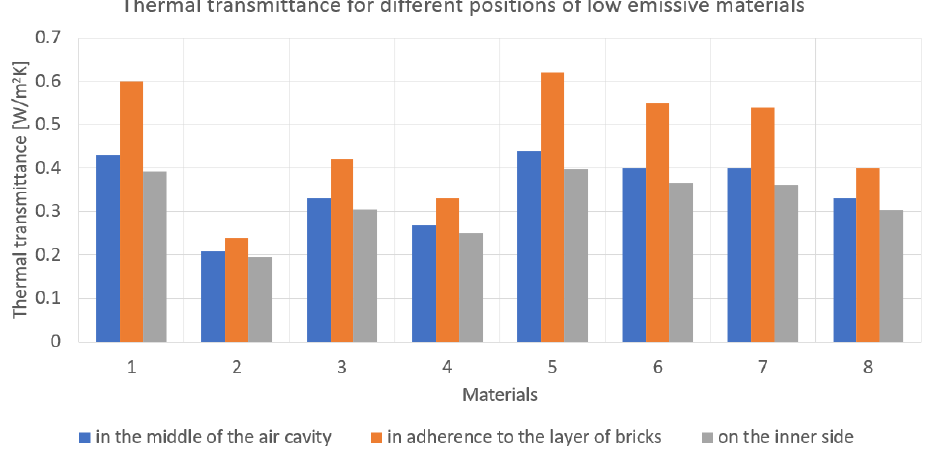
Figure 3. Variation of the thermal transmittances obtained for a cavity wall, positioning the heat reflective layer either in the middle of the air cavity (blue, no contact) or in the air cavity but in contact with the layer of the bricks (orange) or on the inner side of the wall (grey).